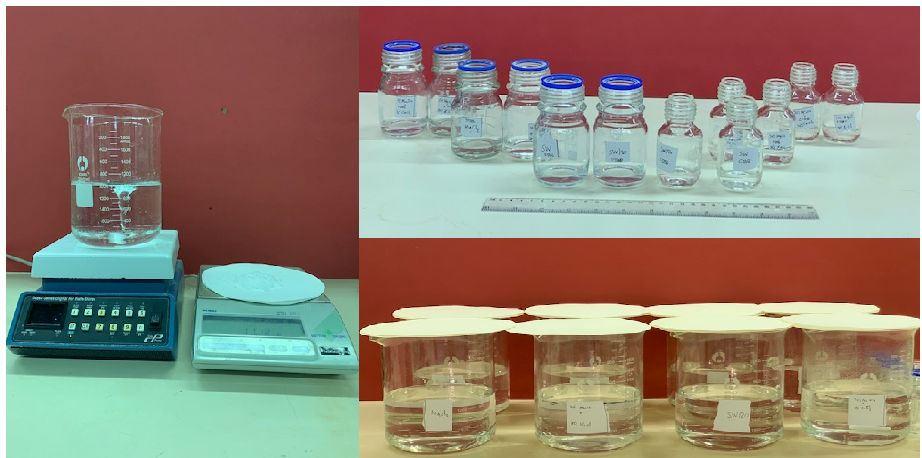
Figure 3. The smart water stock solutions were prepared by mixing controlled amounts of salts with deionized water (at 25 ◦ C and 1 bar); stock solutions were further diluted to 5, 10, 20, and 50 times